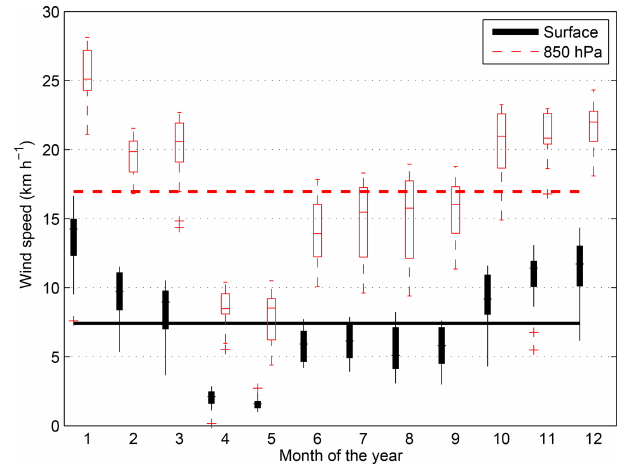
Figure A1. These box plots show the NCEP/NCAR reanalysis long- term climatological monthly mean wind speeds at the surface (filled black boxes) and at 850hPa (open red boxes) in the study area (see Figs. 1, 7, or 8 for study area maps). The solid black and dashed red horizontal lines indicate the annual mean wind speed at the surface and 850hPa ( ∼ 1 . 5km), respectively. Wind speeds that are aloft (on average 17kmh − 1 ) are significantly swifter than those at the sur- face (on average 7.5kmh − 1 ).